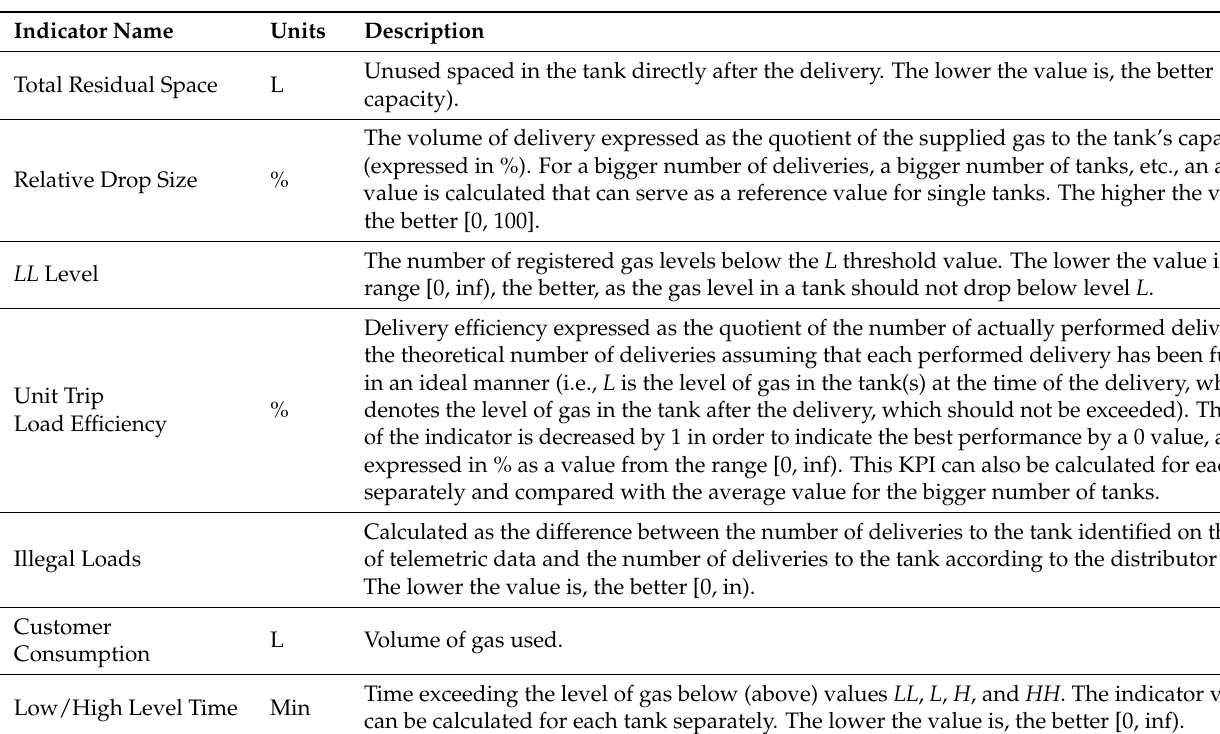
Table 1. KPI examples for the customer tank